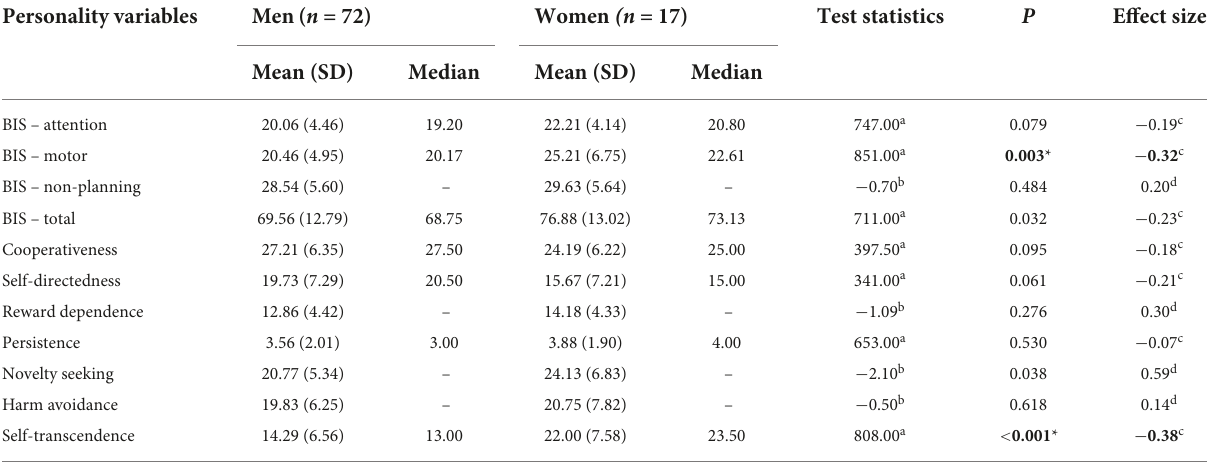
TABLE 3 Comparison of personality characteristics between women and